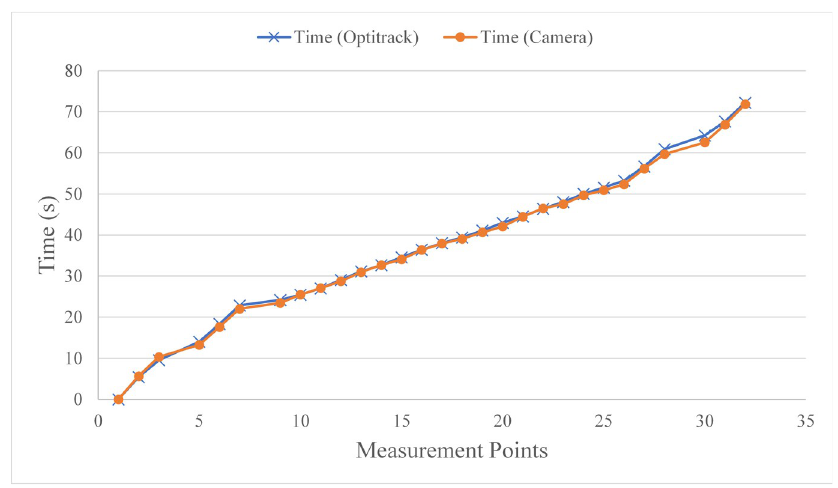
Fig 4. The time one subject passed the measurement points obtained from Optitrack and camera